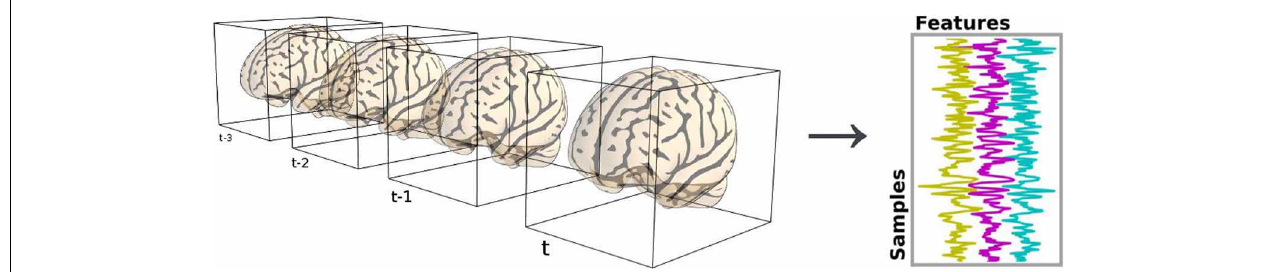
FIGURE 1 | Conversion of brain scans into 2-dimensional